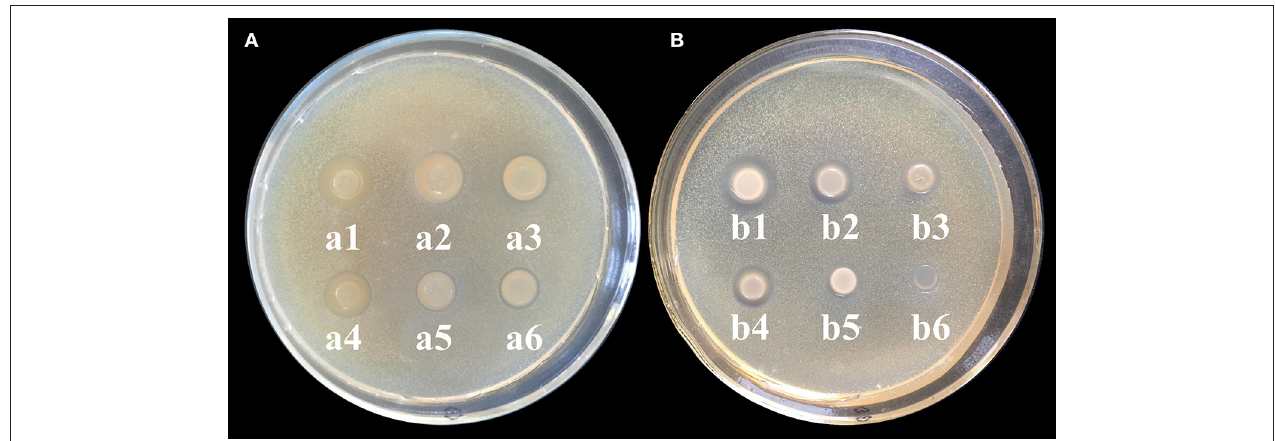
FIGURE 3 | (A,B) Agar diffusion results for S. xylosus and E. coli, respectively. a1 (b1) , a2 (b2) , and a3 (b3) show the inhibition zones for 10, 5, and 2.5 mg/mL CD-g-CS (Q